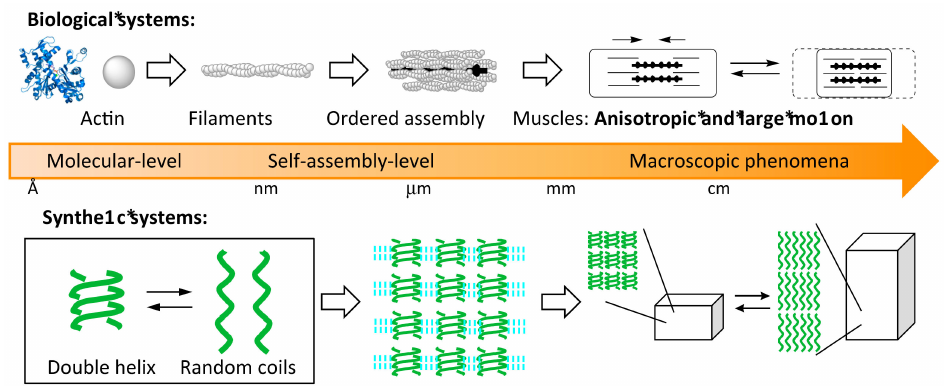
Figure 1. Bottom-up formation of heterogeneous liquid-solid systems derived from self-assembly of molecules. Both biological and synthetic systems are shown.